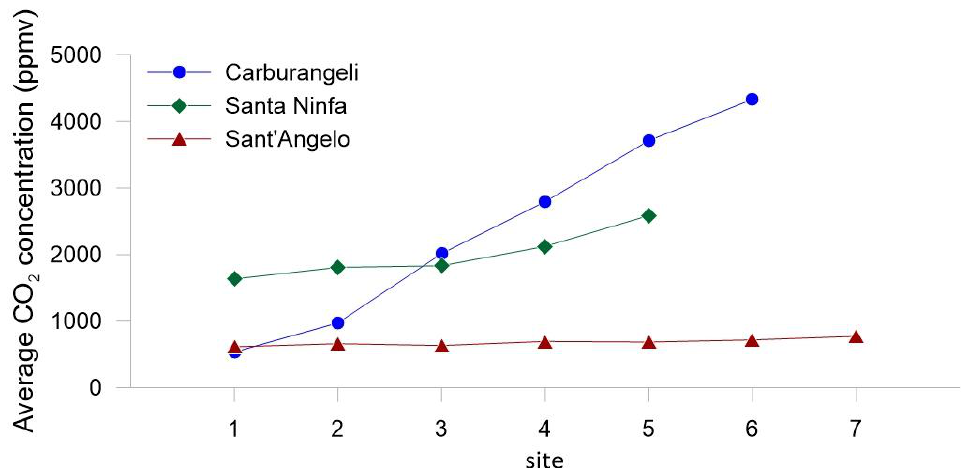
Figure 13. Average values of all air CO 2 concentrations measured inside the caves investigated in this study; refer to Figures 2 – 4 for location of points at Carburangeli, Santa Ninfa and Sant-Angelo caves, respectively.